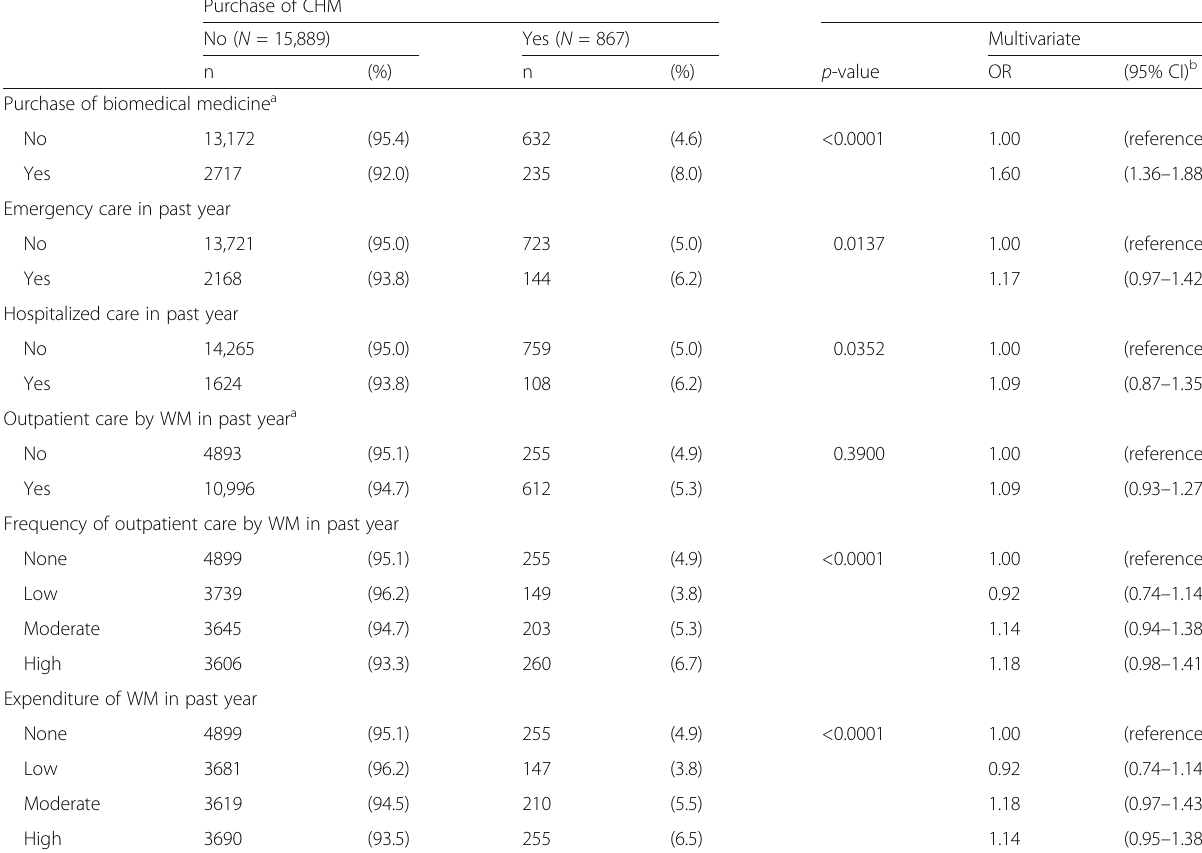
Table 2 Medical care and western medicine use for people with and without purchasing CHM Purchase of